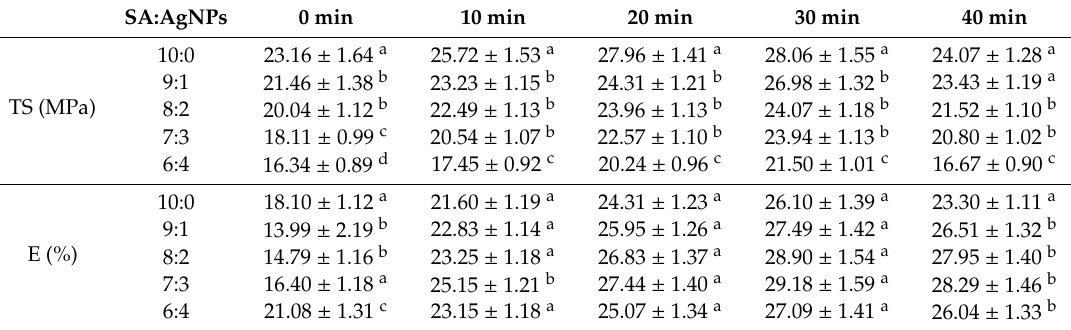
Table 2. Mechanical properties of SA / AgNPs / APP